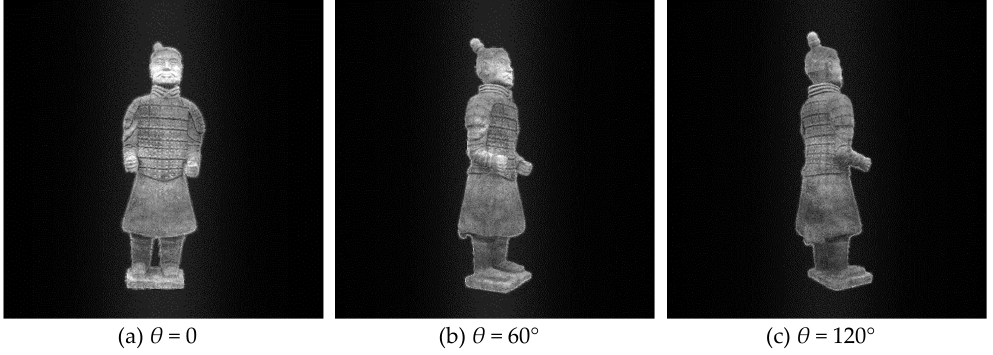
Figure 5. Digital reconstructed images at different viewing angles with kinoform sequence scheme I.